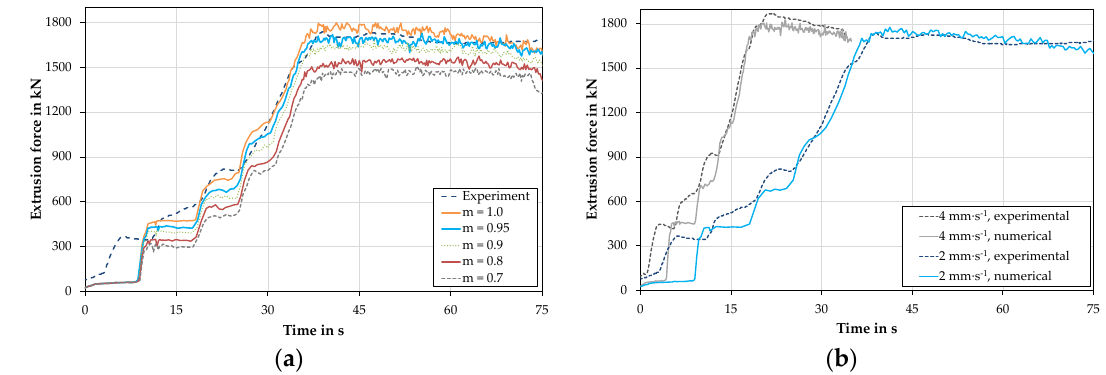
Figure 8. ( a ) Numerically predicted force-time curves for different friction values; ( b ) Comparison of numerically predicted and experimentally measured force-time curves for ram speeds of 2 mm·s −1 and 4 mm·s −1 ( m = 0.95).